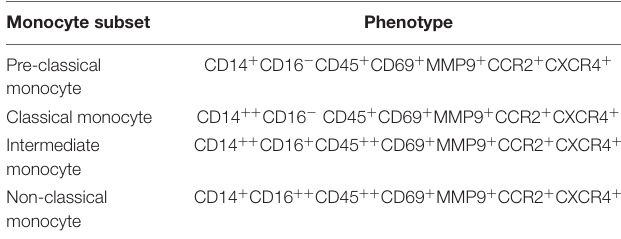
TABLE 2 | Monocyte phenotypic profiles.